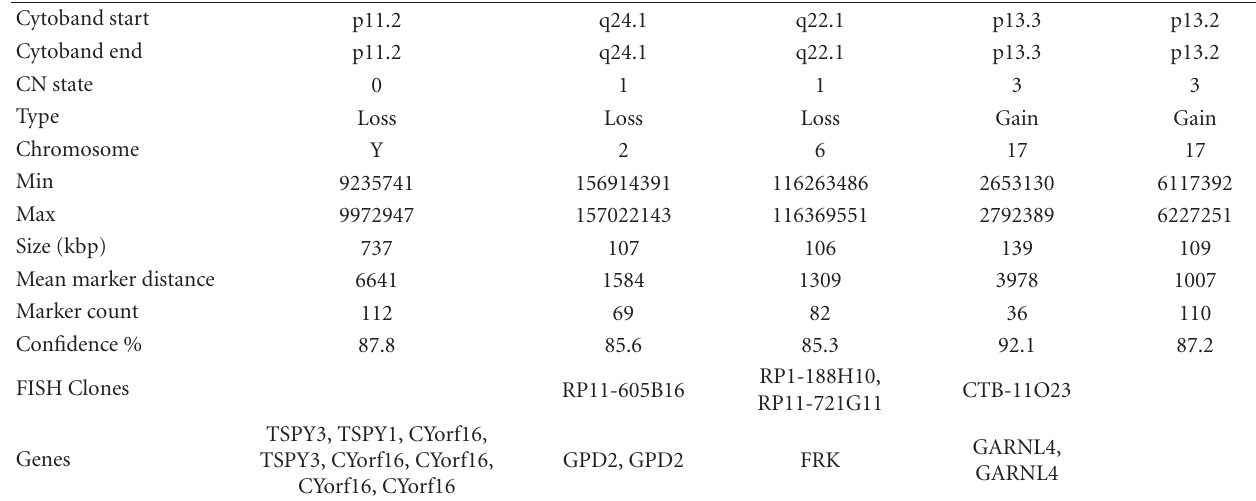
Table 1: Results of the a ff ymetrix cytogenetics whole-genome 2.7 M